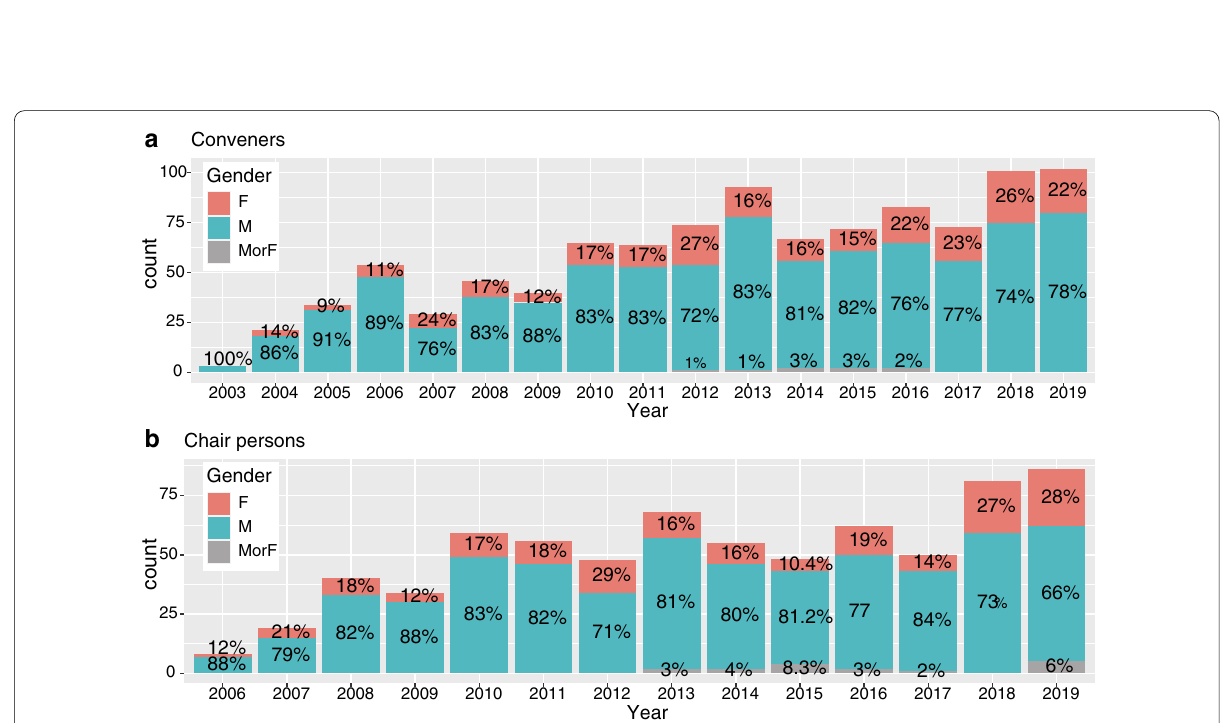
Fig. 5 Number of talk (a) and poster ( b ) presentations per year classified by gender. Percentages are reported on the graph. Contributions for which we were unable to retrieve the gender information are classified as Male or Female (MorF)